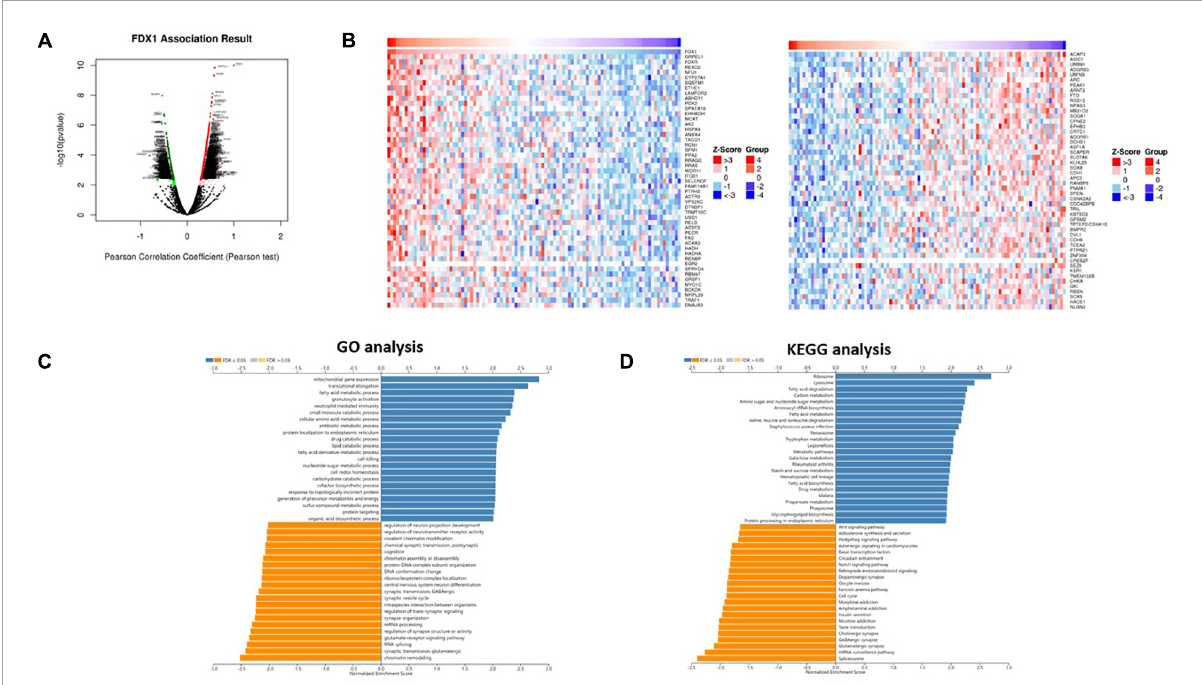
FIGURE6 Co-expression network of FDX1 gene in glioma. (A) The scheme showed FDX1-related differentially expressed genes in glioma. (B) The scheme showed FDX1-related genes in glioma. (C) Genes of FDX1 co-expressed enrichment analysis performed by LinkedOmics (GSEA